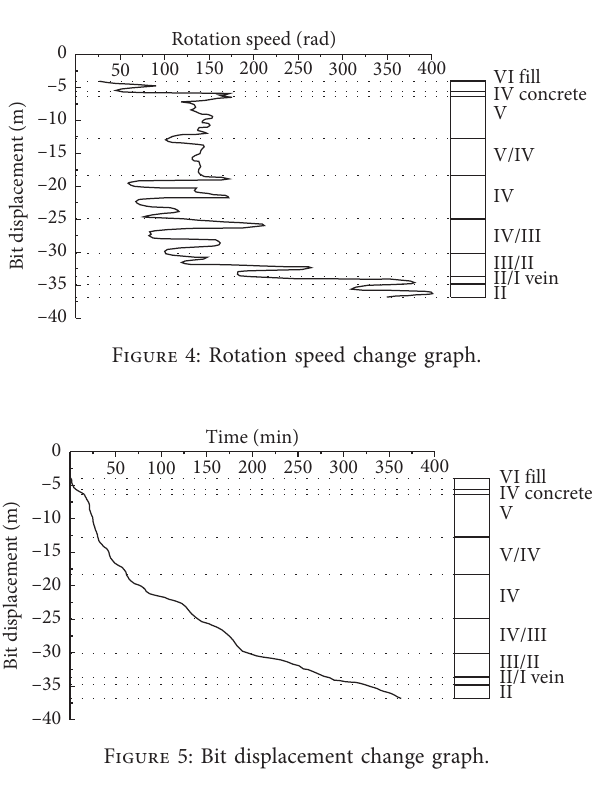
Figure 5: Bit displacement change graph.